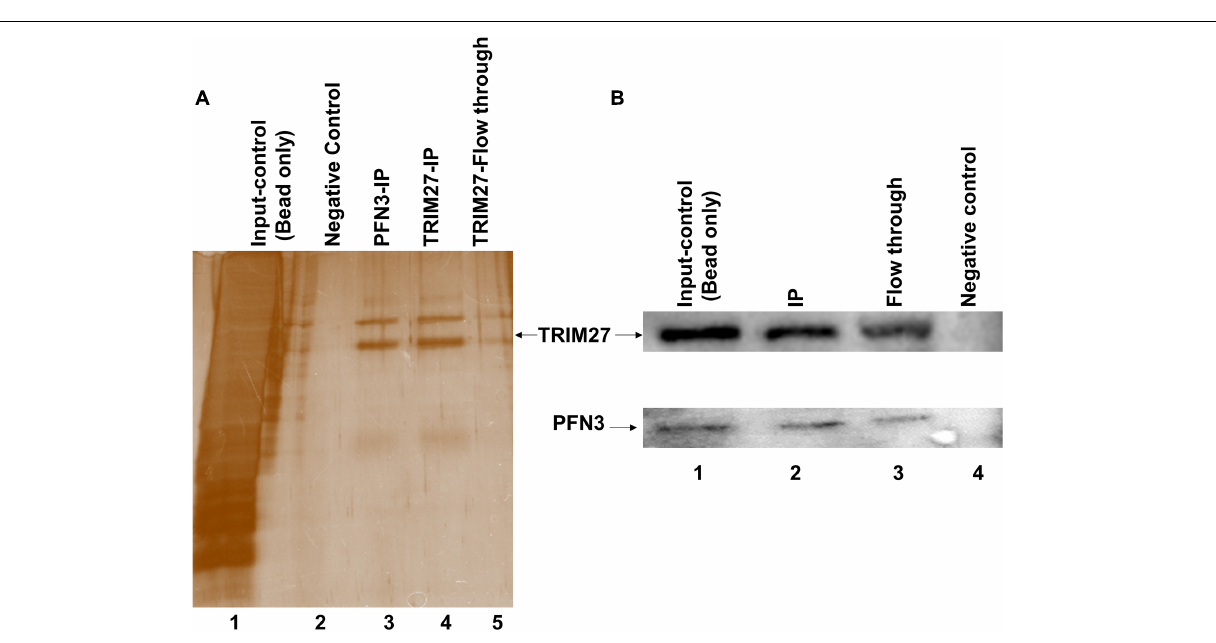
FIGURE 9 | Co-immunoprecipitation using anti-PFN3 and anti-TRIM27 antibody on testis lysates. (A) Silver-stained SDS-PAGE; lane 1: input control (protein lysate), lane 2: negative control (only antibody), lane 3: IP using PFN3 antibody, lane 4: IP using PFN3 antibody, and lane 5: flow through. (B) Western blot showed PFN3 and TRIM27 proteins. Lane 1: input control. Lane 2: immunoblot of reciprocal IP for TRIM27 (band observed at ∼ 58 kDa) and PFN3 protein levels (band observed at ∼ 14 kDa) using anti-PFN3 and anti-TRIM27 antibodies, respectively. Lane 3: flow through. Lane 4: negative